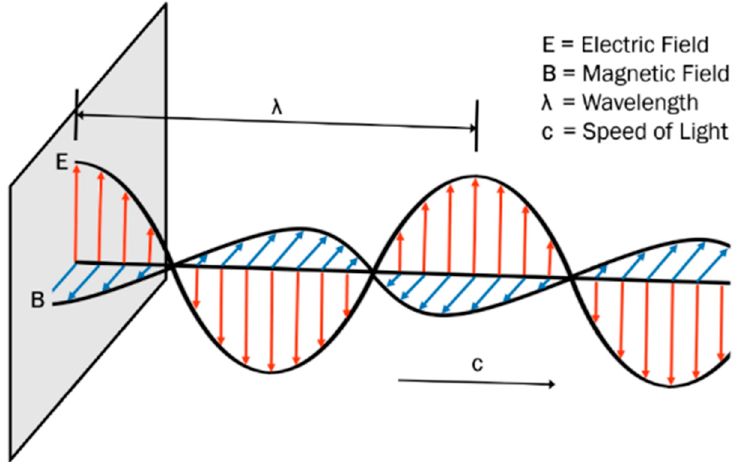
Figure 3 . Electric (E) and magnetic (H) field components in microwaves [45].